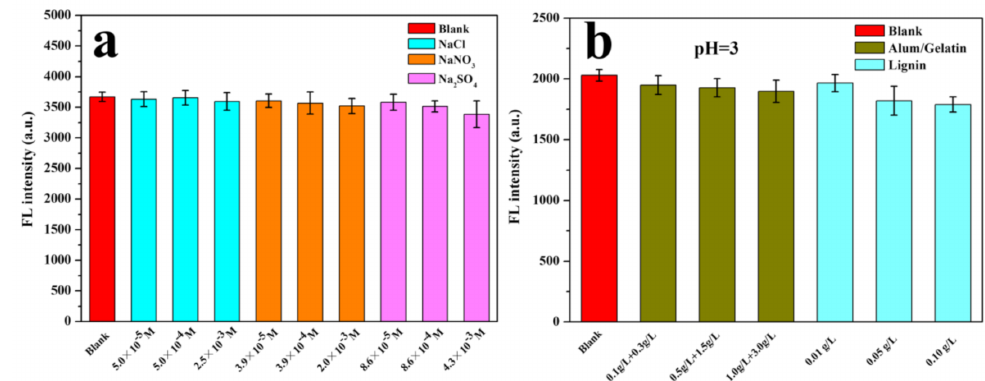
Figure 7. ( a ) The fluorescence intensities of CdZnSeS-pATP QDs at 537 nm in presence of NaCl, NaNO 3 and Na 2 SO 4 at different concentrations. The error bars represent the standard deviations of four measurements. ( b ) The fluorescence intensities of CdZnSeS-pATP QDs at 537 nm in presence of gelatin-alum and lignin at different concentrations, at a pH of 3. The error bars represent the standard deviations of four measurements. (C QDs = 1.15 × 10 − 4 mg/mL, Water:DMSO = 150:1( V / V ), λ ex = 365